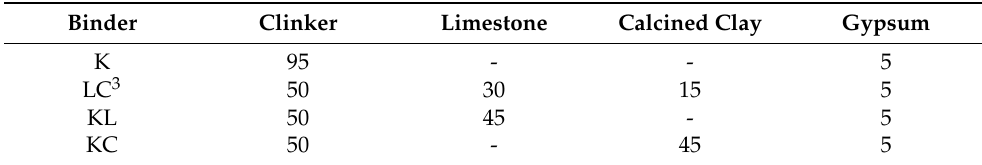
Table 2. Summary of the proportion of various binders (wt %).